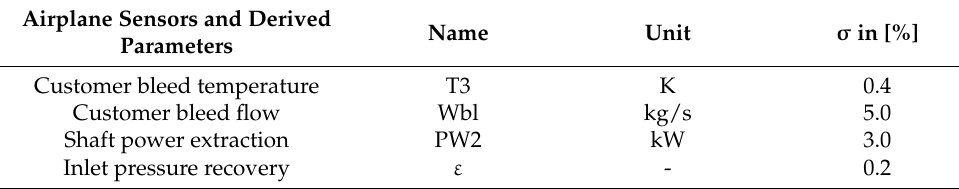
Table 3. Airplane sensors and derived parameters.